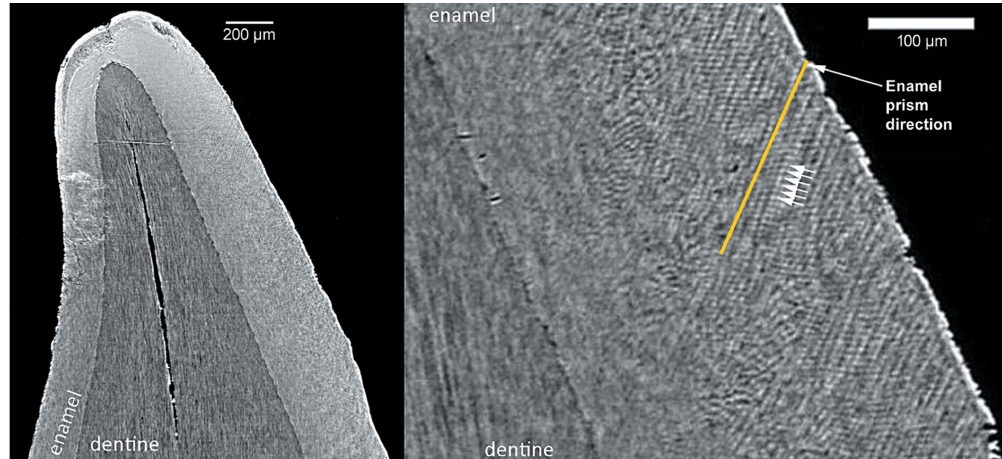
Figure 3 Velia 387 lower deciduous central incisor. Vestibular-lingual reformatted images from SR m CT, isotropic voxel size = 1.3 m m, slice thickness = 1.3 m m. The fine enamel microstructures are discernible. On the right, the magnification of a portion of the left image shows enamel prisms (yellow line) and cross striations (white arrows). Each dark-and-bright couple highlighted by the white arrows represents a single cross striation, i.e. 24 h of enamel deposition.